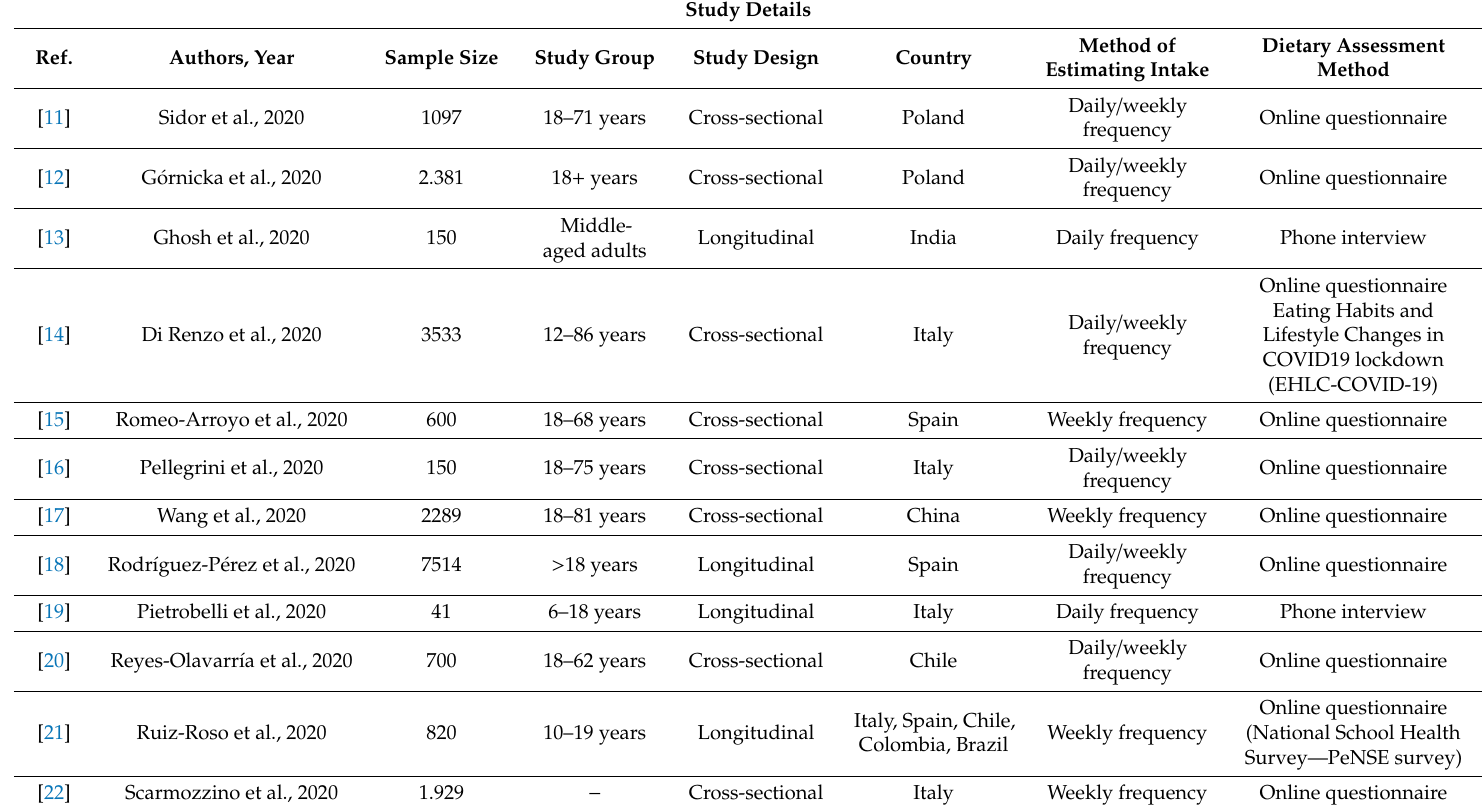
Table 2. Descriptive characteristics of included